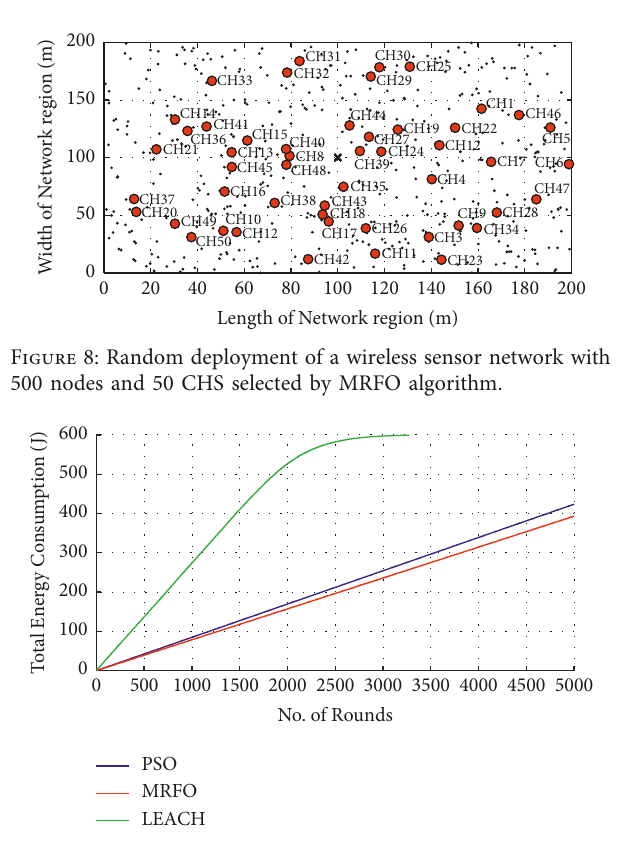
Figure 12: Total energy consumption for 400-node network, 40 CHs when the BS is at the center of ROI.